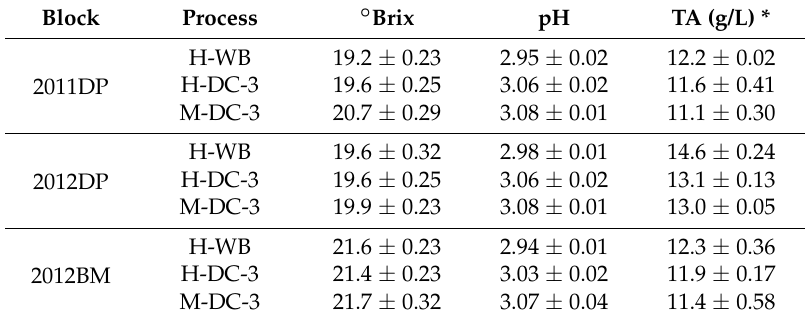
Table 2. Analysis of total soluble solids and acidity in grapes harvested in three blocks ( n =